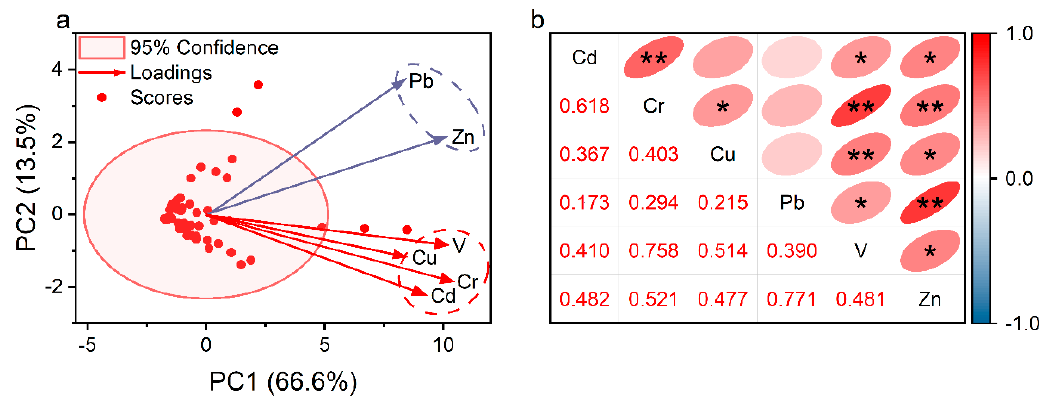
Figure 3. Principal component analysis ( a ) and correlation coefficient matrix ( b ) of trace metals in agricultural soils around the V-containing stone coal smelting site. *, p < 0.05. **, p < 0.01.